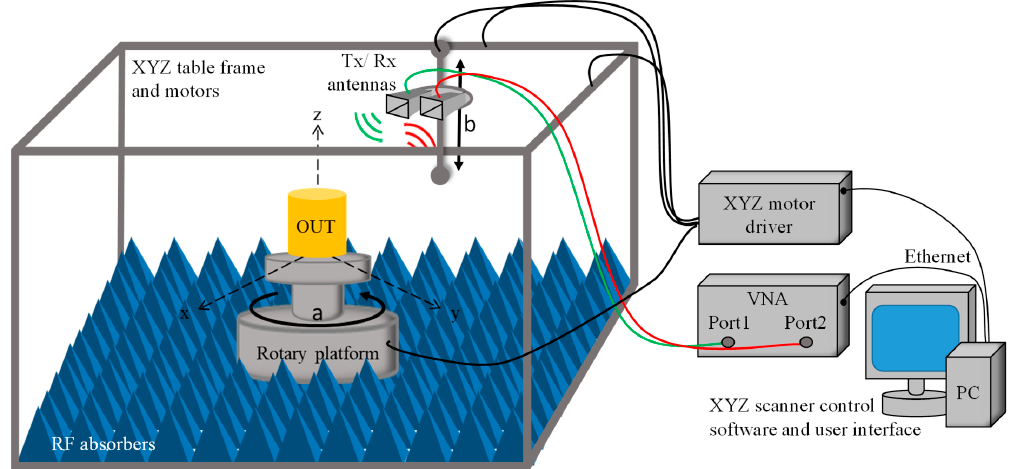
Figure 4. Scheme of the measurement for dielectric objects imaging using a rotary platform and vertical slider. Tx and Rx antennas are placed according to a quasi-monostatic configuration with respect to the OUT. Full (360°) angular rotation ( a ) is allowed. Vertical motion range is b = 27 cm. SGH aperture size is 5.6 × 4.4 cm [25], so D SGH = (5.6 × 4.4) 1/2 = 5 cm. The far field distance is R FF = 2( D SGH ) 2 / λ = 29.4 cm at f = 18 GHz. As the distance between the Tx/Rx antennas and the center of the rotary platform is 89 cm, then, the OUT is placed in the far field region of the antennas. Besides, for this SGH, -3 dB antenna beamwidth ( θ − 3dB ) ranges from 25.5° at 18 GHz, to 37° at 12 GHz. That means that, at the distance of 89 cm, the θ − 3dB is wider than 42.5 cm in the working frequency band, thus fully covering the area where the OUT is